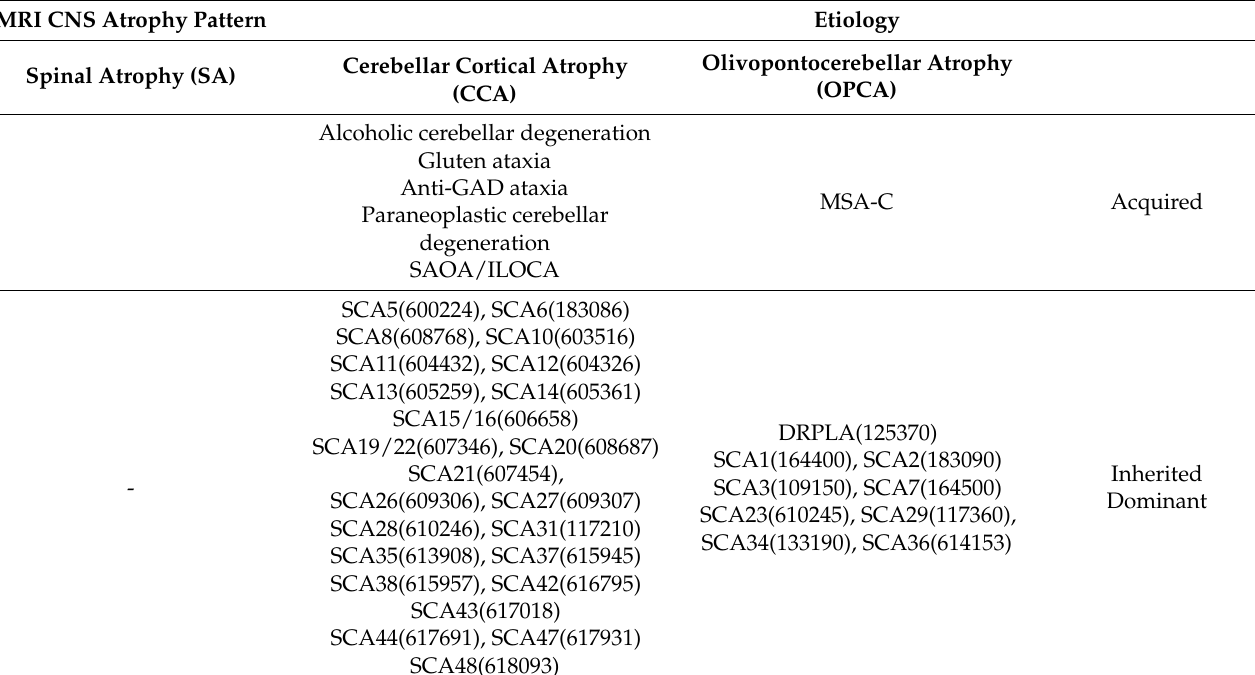
Table 1. MRI CNS atrophy pattern and etiologies in progressive